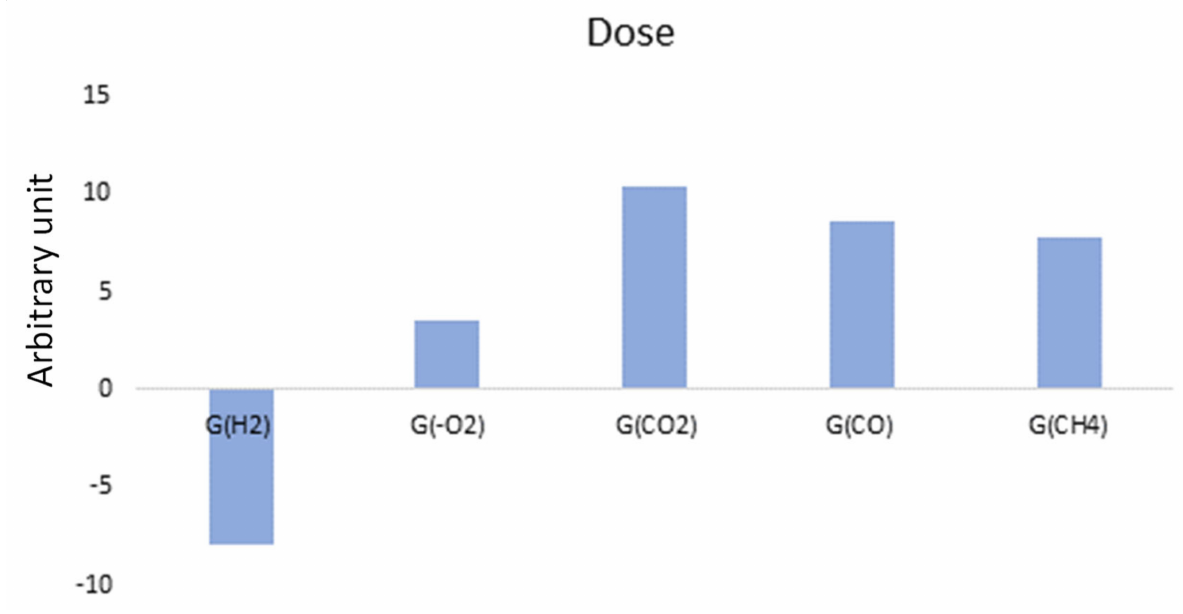
Figure 21. CCs loading depending on the UJV irradiation